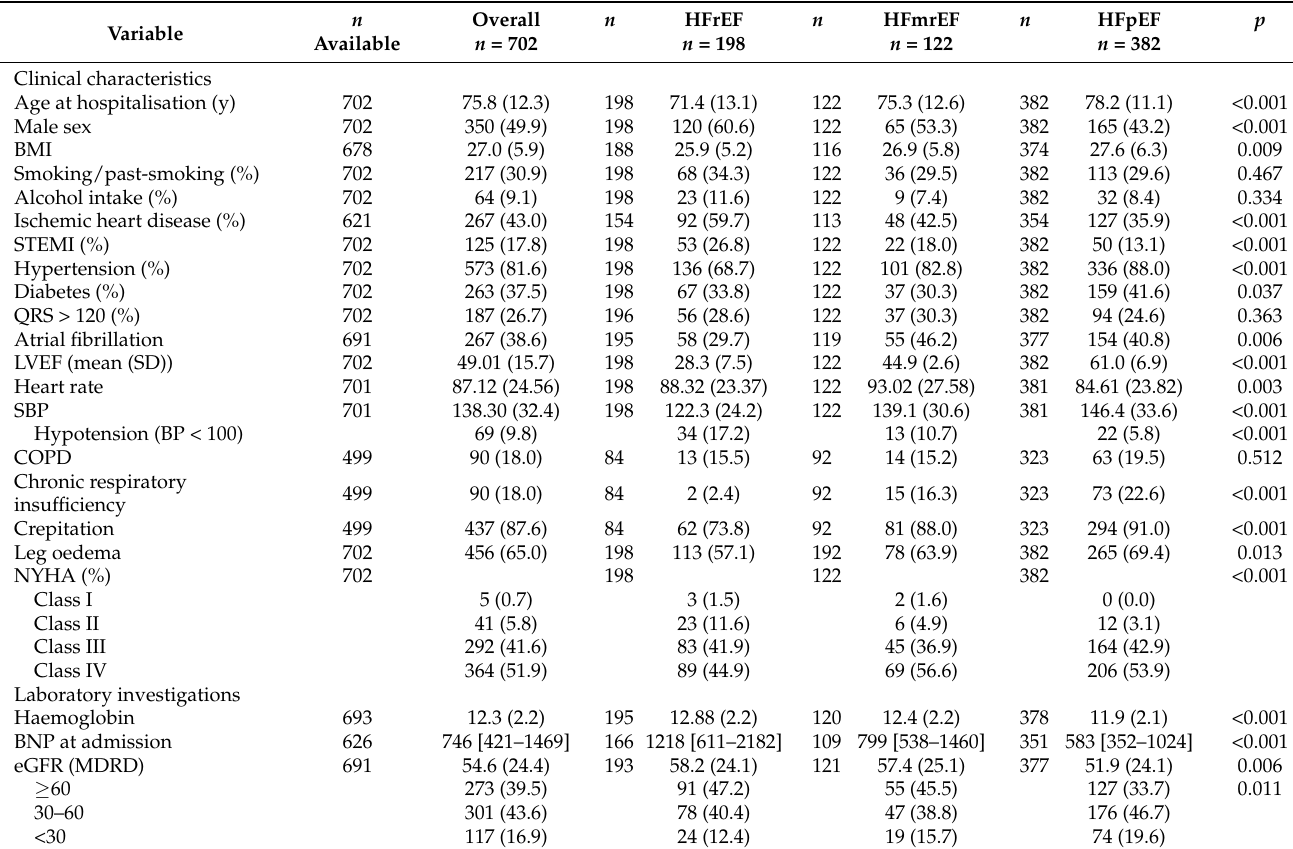
Table 2. Baseline patient characteristics according to HF phenotype § .